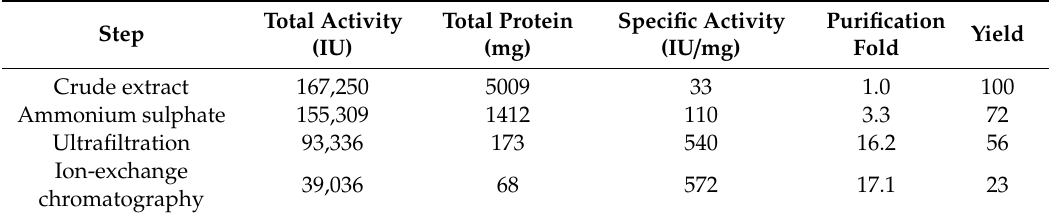
Table 9. Purification of xylanase from A.